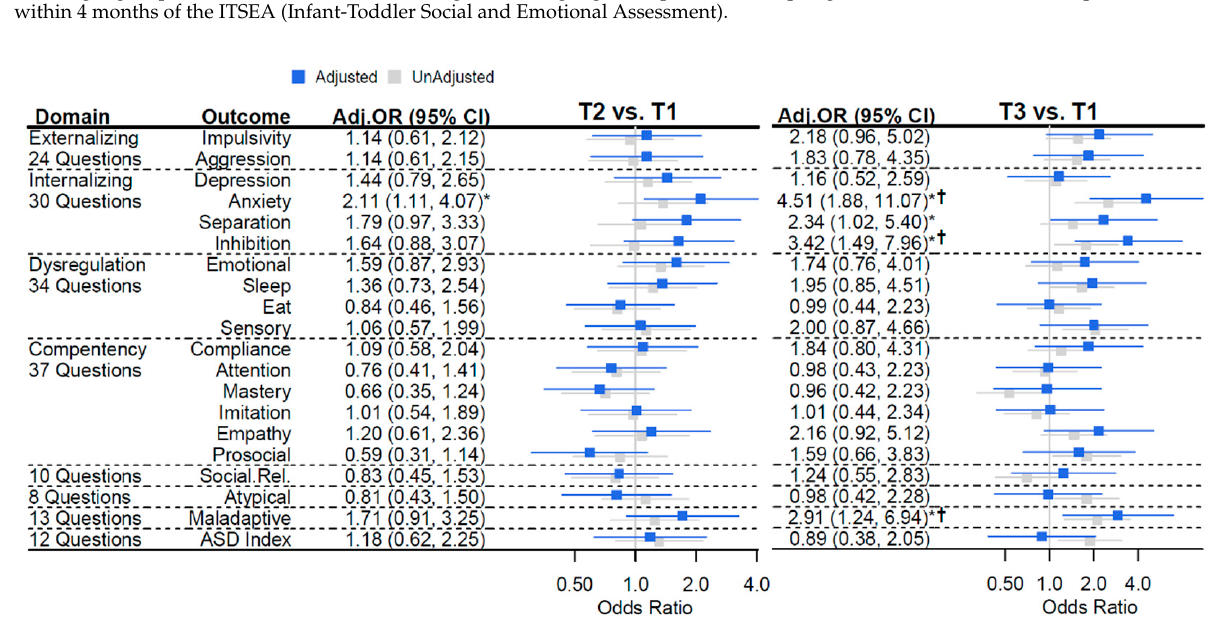
Figure 1. MGL and child temperament. For a given tertile of MGL compared to tertile 1 (referent), the odds ratio (95% confidence interval) represents the risk of being in a higher tertile of behavioral outcome. Unadjusted (gray) and adjusted (blue) odds ratios (95% confidence intervals) are plotted. Estimates were adjusted for breastfeeding at least 3 months, age of child at behavioral assessment, maternal fiber intake, total calories, folate, education, diabetes, obesity, smoking, and age, as well as child parity, premature birth, weight, race, and child sex. * p < 0.05; † Benjamini–Hochberg FDR < 0.10.